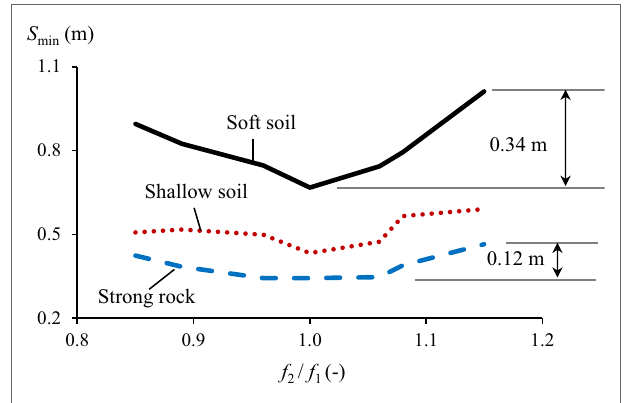
FigUre 11 | Minimum total gap required for an MeJ to avoid pounding between segments 1 and 2 due to highly correlated ground motions with ssi